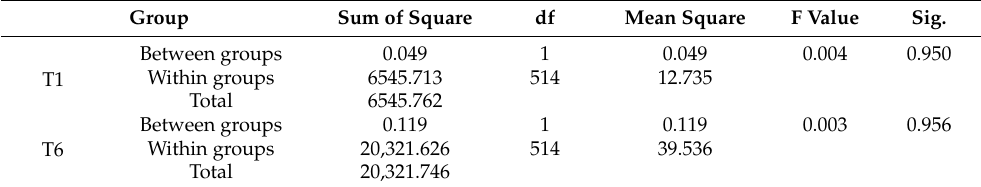
Table 4. The result of the test for independence of two plants in each group. Group Sum of Square Mean